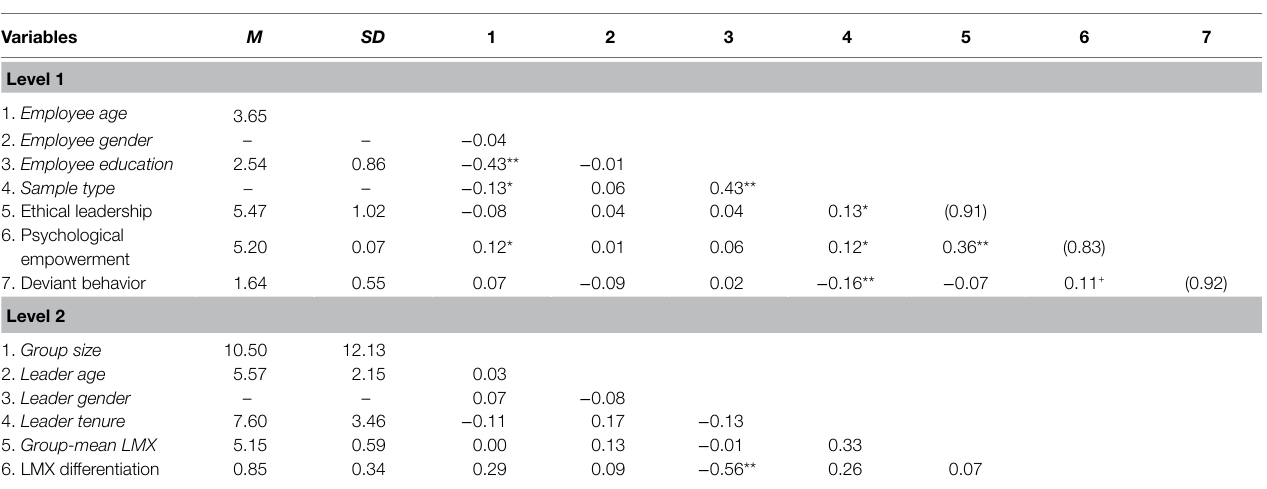
TABLE 1 | Means, SDs, reliability coefficients, and correlations of study variables.